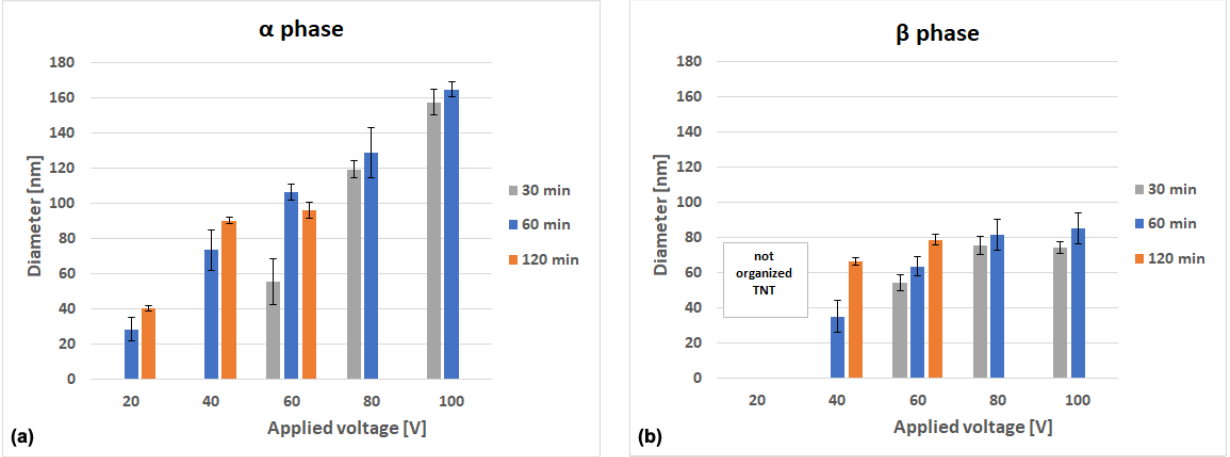
Figure 7. Average inner nanotubes diameter as a function of applied potential and anodization time for the conditions where open nanotubes were observed. ( a ) α -phase nanotubes and ( b ) β -phase nanotubes.